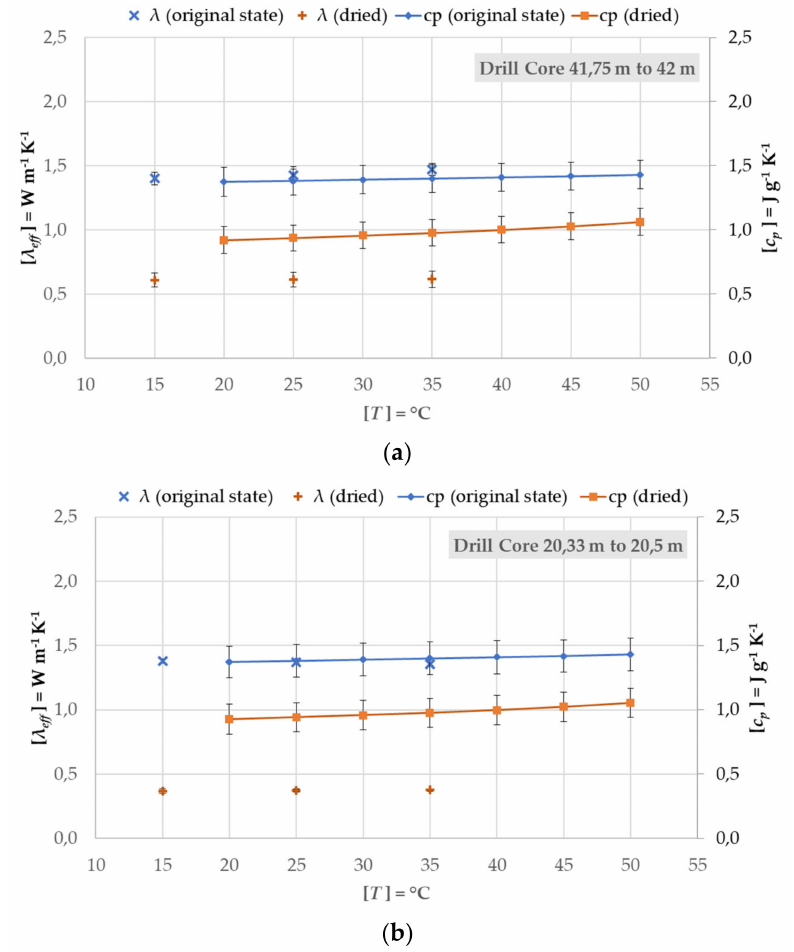
Figure 10. Summary of the results of λ ef f ( T ) and c p ( T ) at ( a ) 41.75–42 m and ( b ) 20.33–20.5 m depths in moist and dry